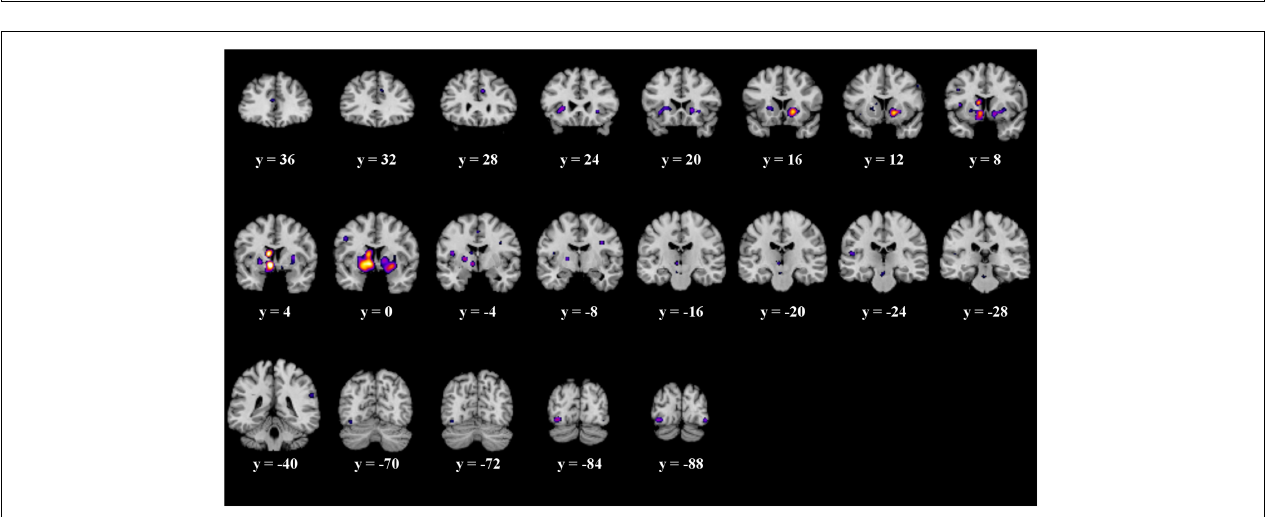
FIGURE 5 | Overview of the meta-analysis results of the behavior – no behavior subtraction analysis ( p < 0.05, uncorrected). The significant clusters are comprised of activity in the putamen, caudate head, caudate body, insula, medial globus pallidus, and the fusiform gyrus (from left to right). MNI coordinates are presented below each coronal view.